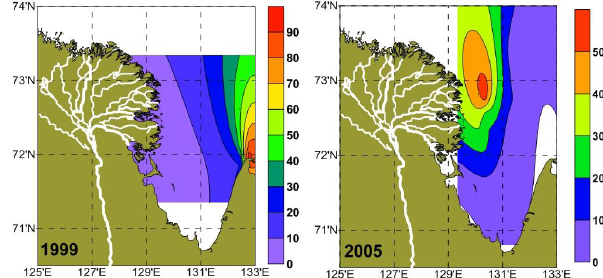
, 2 ) from the shallow 2